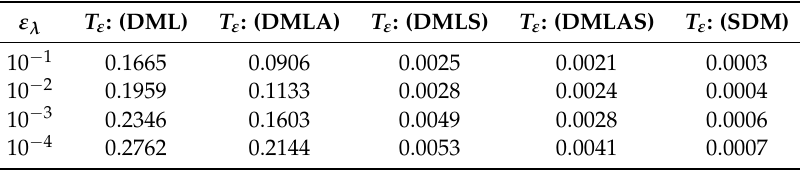
Table 4. Results for Case QL with J = 510, m = 25.